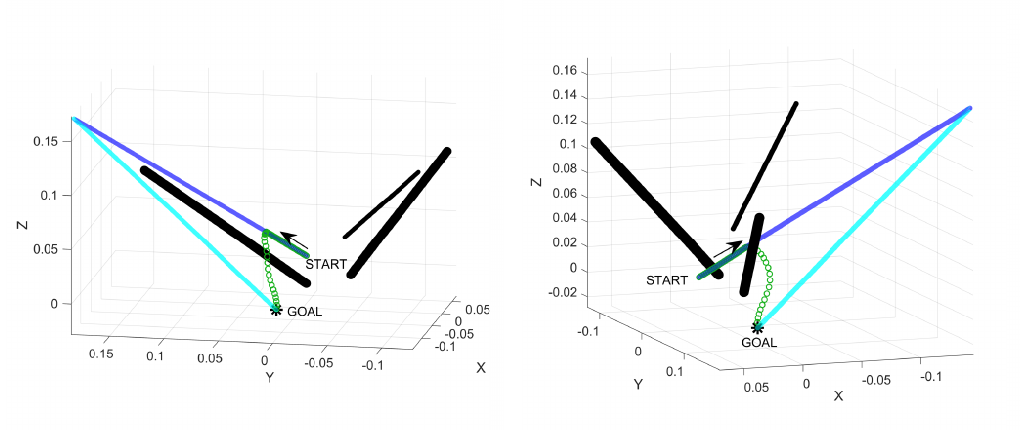
Figure 5. In blue, the starting pose of the robot, while in light-blue, the goal pose. In black, the obstacles. In green, the trajectory of the